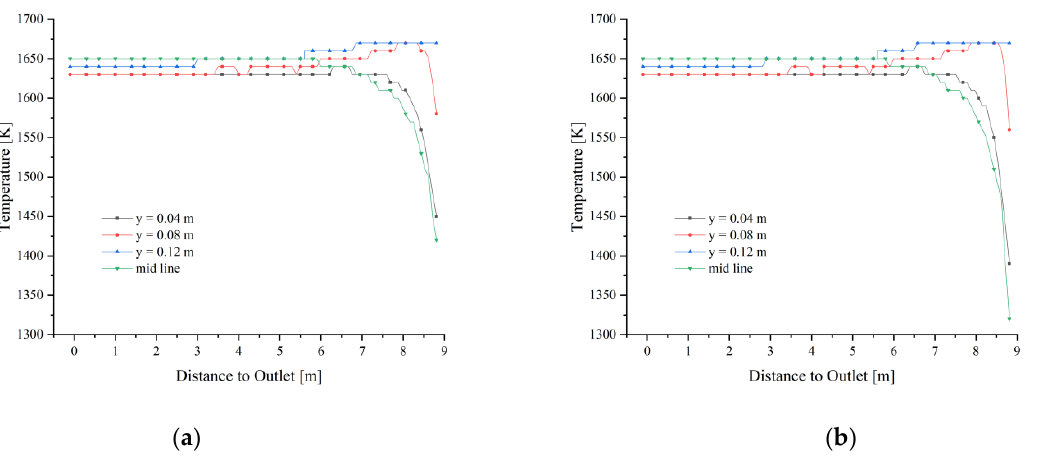
Figure 13. Solid temperature changes in the calcination zone at 40 mm and 120 mm. ( a ) Solid temperature of 40 mm; ( b ) Solid temperature of 120 mm.